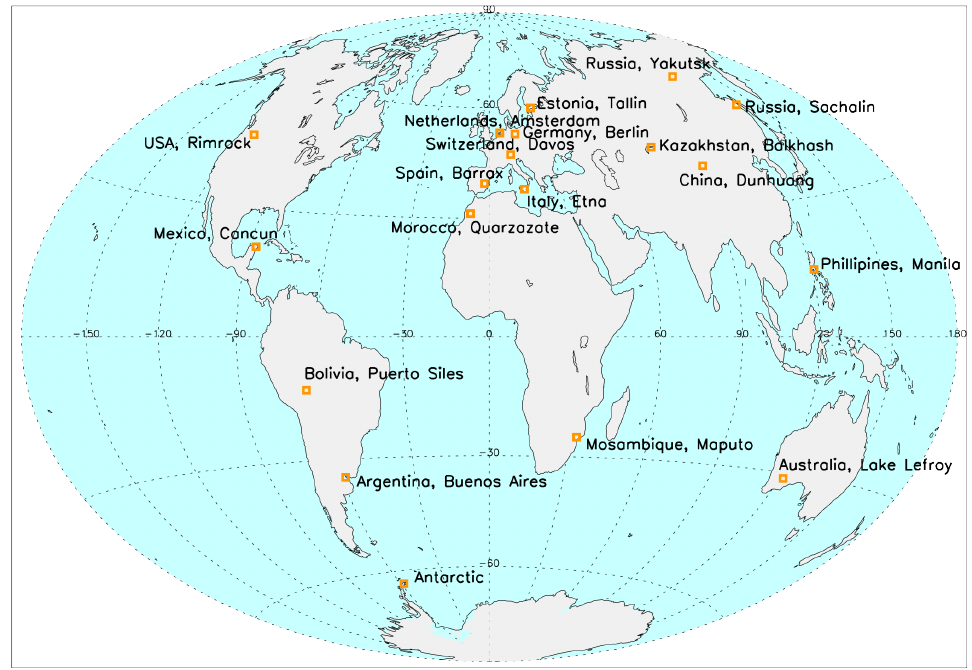
Figure 1. Geographical distribution of 20 test sites selected for validation (orange